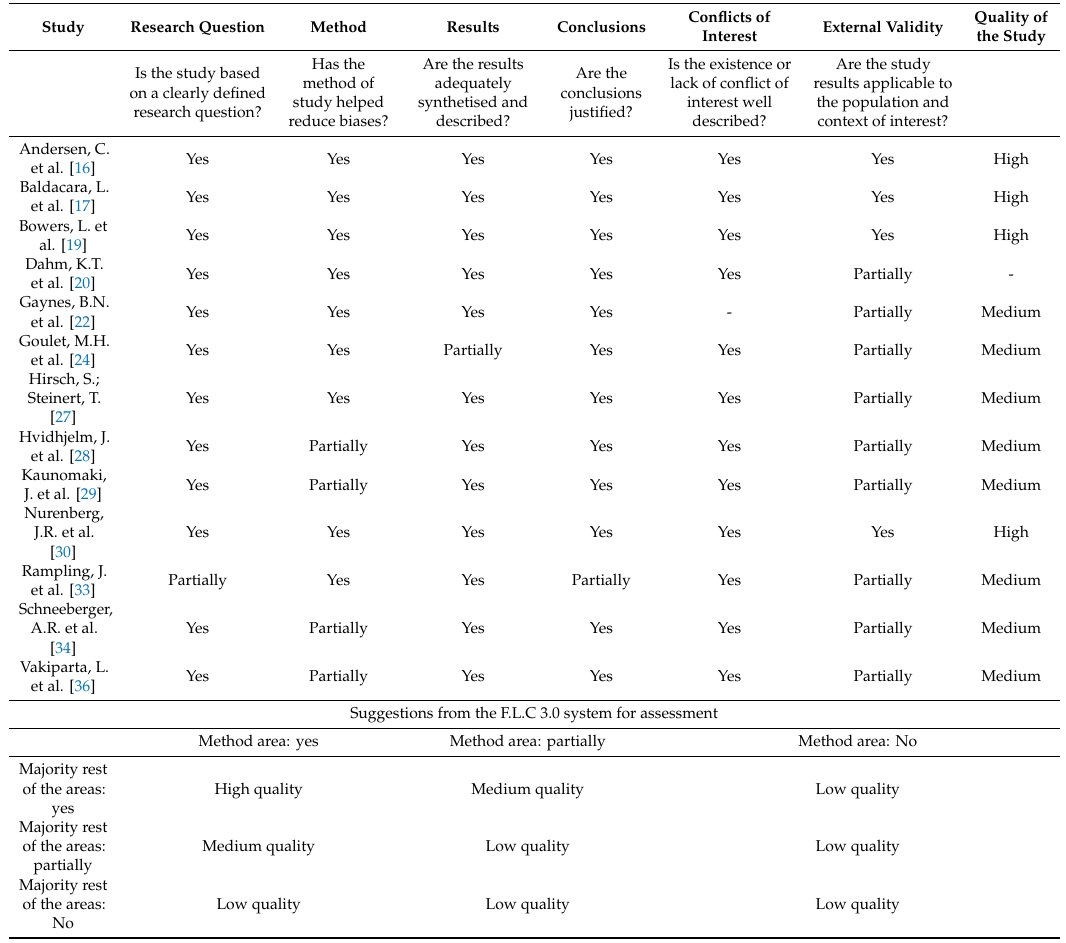
Table 5. Results of the methodological quality assessment (FLC 3.0)